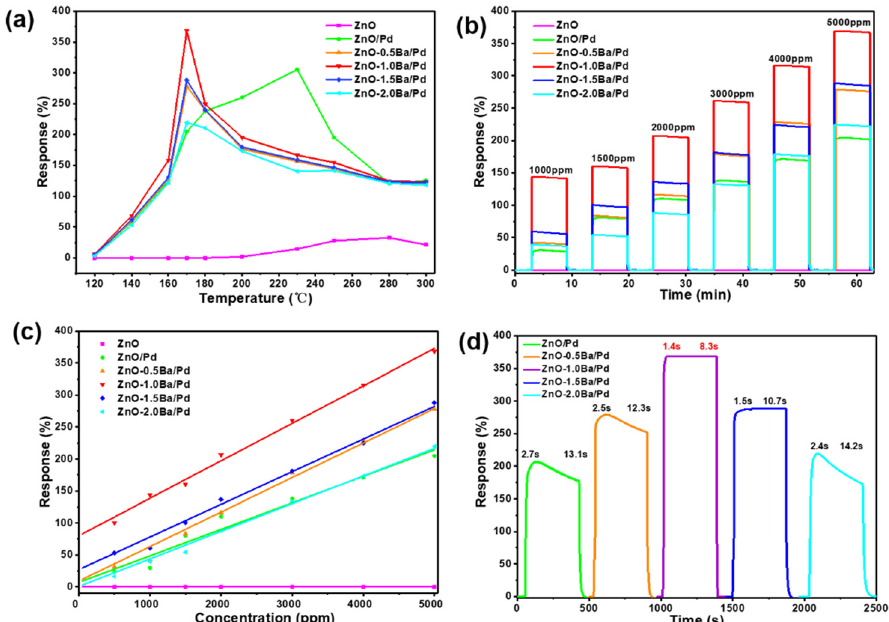
Figure 4. Gas sensing properties of ZnO/Pd, ZnO-0.5Ba/Pd, ZnO-1.0Ba/Pd, ZnO-1.5Ba/Pd, and ZnO-2.0Ba/Pd for 5000 ppm CH 4 : ( a ) response at different working temperatures (120–300 °C), ( b ) dynamic response (1000–5000 ppm), ( c ) relationship of the gas response to CH 4 gas concentration (1000–5000 ppm), ( d ) response and recovery curves of sensitive materials.